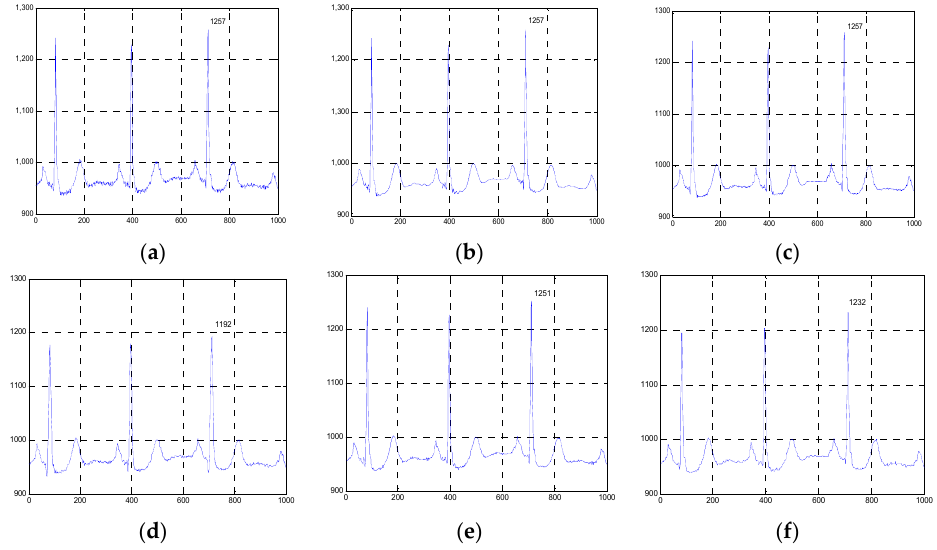
Figure 10. Comparison of the denoised results for all evaluated methods operating on the 100m.dat in the first group of clinical ECG signals. ( a ) The clinical ECG signal, ( b ) the ESMD-NLM method, ( c ) the NLM method, ( d ) the EEMD method, ( e ) the VMD method, ( f ) the MED